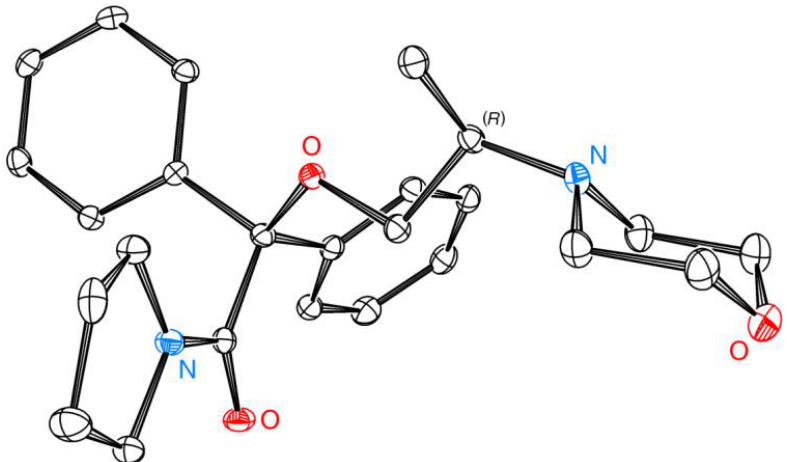
Figure 7. An ORTEP plot of 2-[(2 R )-2-(morpholin-4-yl)propoxy]-2,2-diphenyl-1-(pyrrolidin-1- yl)ethan-1-one (( R )-( – )- 10 ). The following crystal structure has been deposited at the Cambridge Crystallographic Data Centre and allocated the deposition number CCDC-2202212. Ellipsoids are set to 50% probability, and hydrogen atoms have been omitted for clarity. ORTEP plot was prepared in Ortep-3 for Windows (WinGX version 2021.3) software (Glasgow, Scotland) [63].